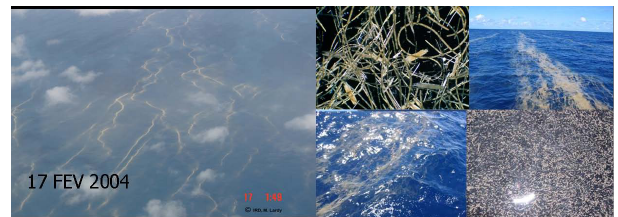
Fig. 2. Photographs of the January–February 2004 Trichodesmium slick as seen from long line airplanes (aerial observation), and from the ship of the French Navy La Glorieuse (shipboard observation with bucket sample) reported in Table